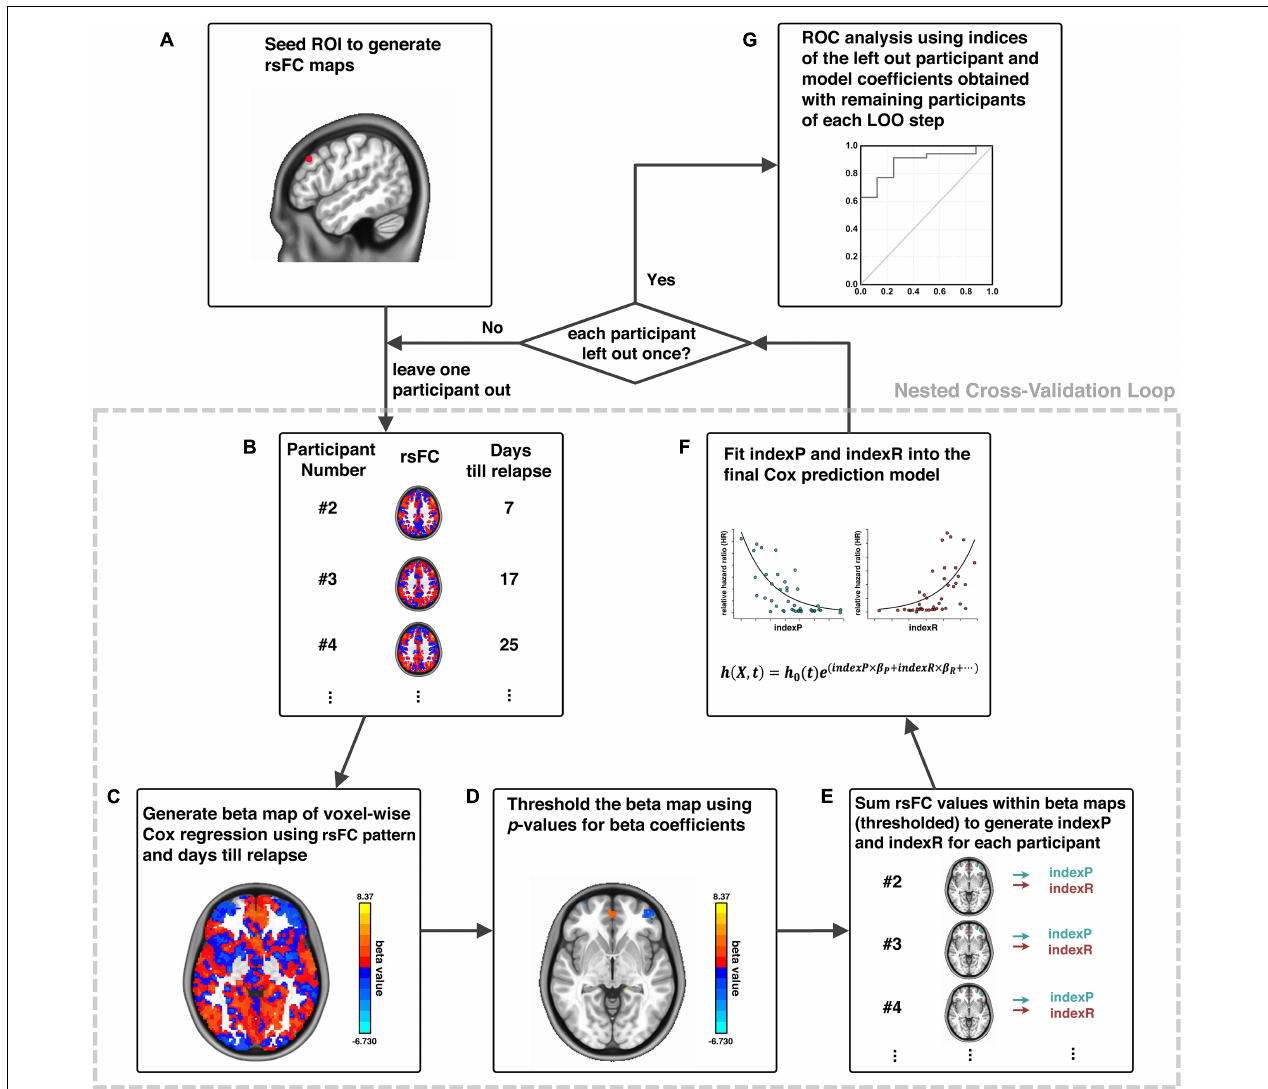
FIGURE 1 | Schematic diagram of analytical pipeline. Illustration of our analytical procedures using one exemplar seed ROI, adapted from Zhai et al. (2021). First, an ROI is selected as a seed (A) ; the whole-brain rsFC of this seed is calculated for each participant (B) ; a voxel-wise Cox regression is conducted using rsFC and days until relapse to generate beta maps (C) ; beta maps of Cox regression is thresholded (D) ; generation of indexP and indexR by linearly summation of the rsFC values within the thresholded beta maps for the negative and positive beta voxels, respectively (E) ; construction of the final prediction model by fitting indexP and indexR into the Cox model (F) ; procedures B to F were organized in a nested cross-validation loop, and after each participant is left out once, an ROC analysis evaluates the final prediction model (G) . rsFC, resting-state functional connectivity; ROI, region-of-interest; ROC,